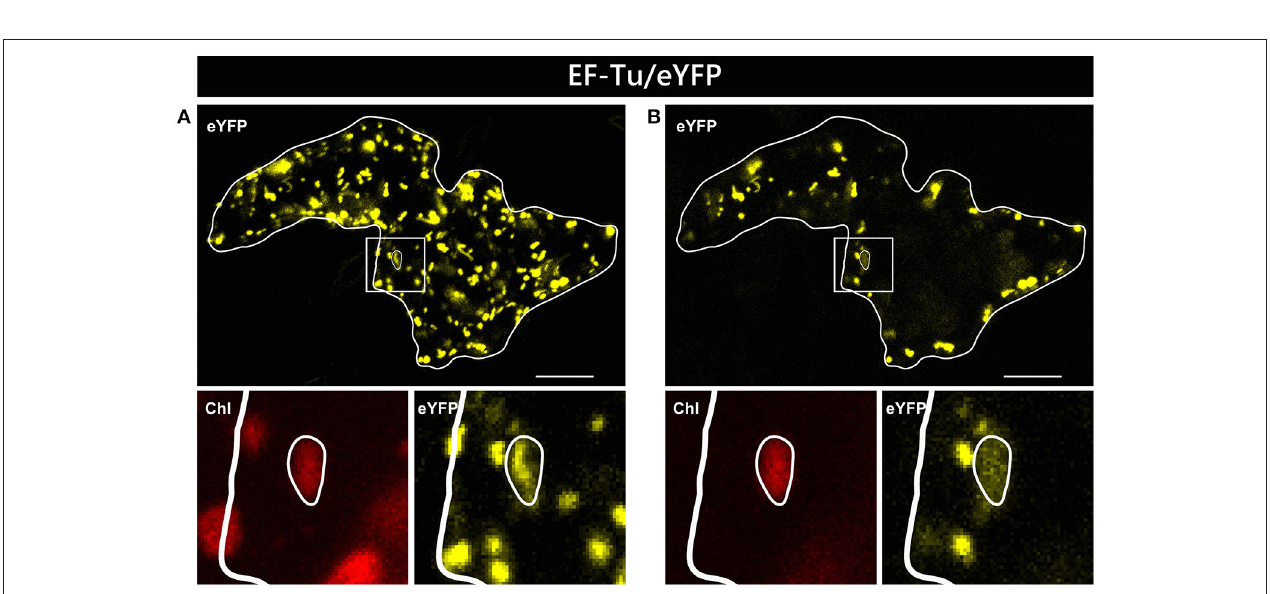
FIGURE 3 | Alternative visualization of EF-Tu/eYFP localization in epidermal cells. The same epidermal cell of Arabidopsis thaliana transiently transformed by particle bombardment with the EF-Tu/eYFP construct is shown either as maximum intensity projection of several single images representing the complete cell in z-axis (A) or as a single plane image from the same acquisition (B) . In the areas below the overview pictures, separate images of eYFP and corresponding chlorophyll channels are shown at higher magnification. For further details see the legend of Figure 1 .